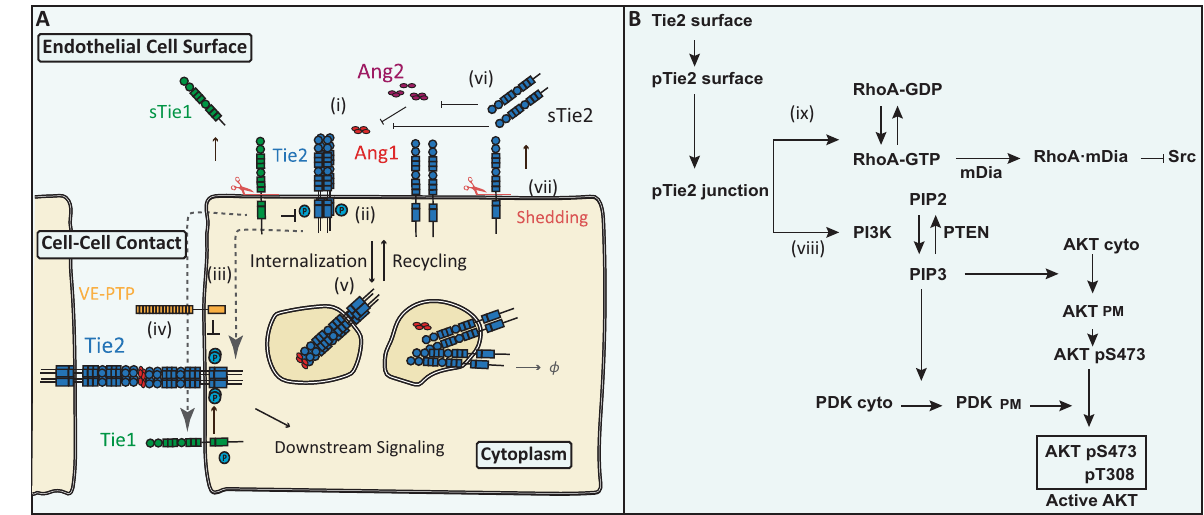
Fig. 1 Diagram of the model assumptions. A Ligand receptor interactions, receptor dynamics, and molecular regulatory mechanisms . Tetrameric Ang1 and multimeric Ang2 induce the multimerization, internalization, activation, and junctional localization of Tie2. Tie1 binds and inhibits Tie2 at the luminal surface but binds to Tie2 and sustains its activity at cell – cell junctions. Extracellular domains of Tie1 and Tie2 are cleaved from the cell surface to form soluble receptors. Soluble Tie2 acts as a ligand trap to bind both Ang1 and Ang2. B Downstream signaling of Tie2 . Activated Tie2 sequesters Src kinase through RhoA and mDia and activates Akt via